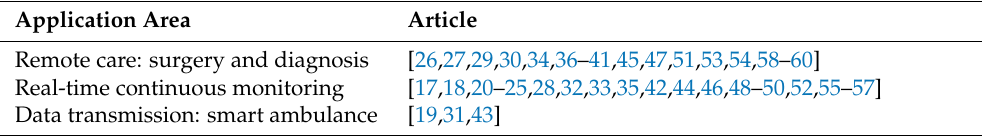
Figure 5. Application area. Table 2. Summary of articles according to the application